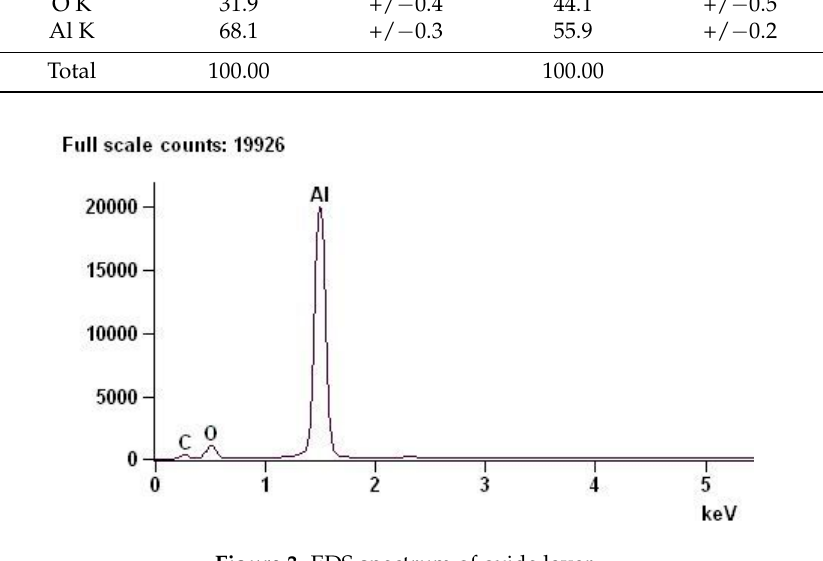
Figure 3. EDS spectrum of oxide layer.